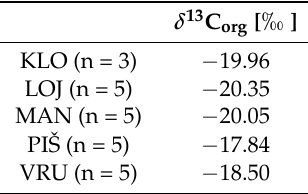
Table 1. Average values of δ 13 C org in the sediment, (n = number of samples collected).